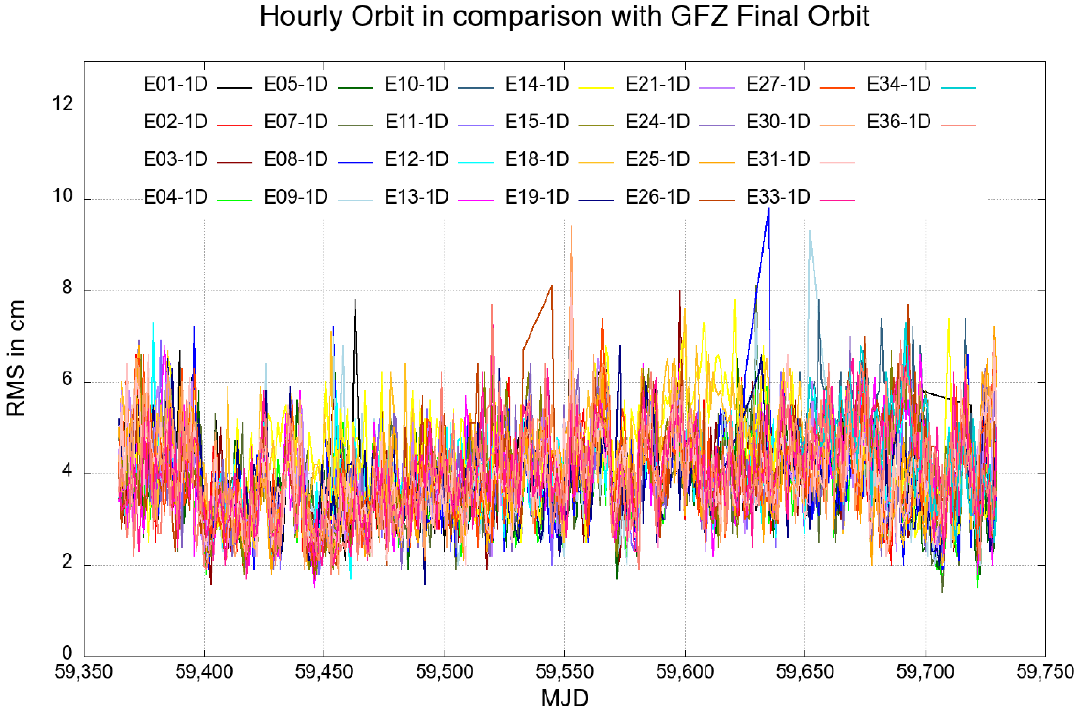
Figure 12. Time series in 1-D of Galileo satellites compared with GFZ final orbit.